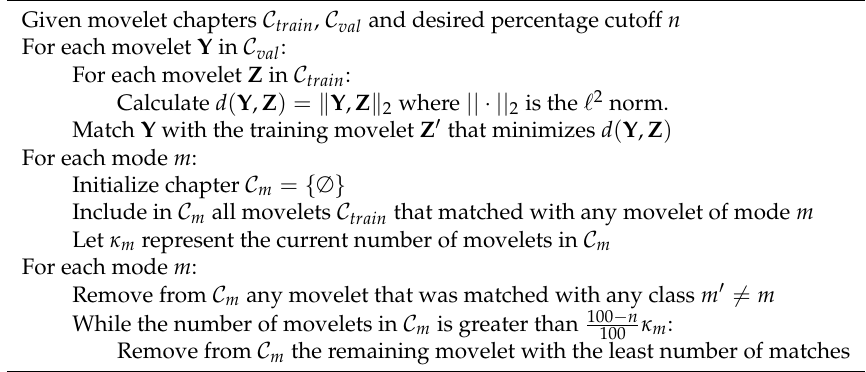
Algorithm 2 Pseudocode for Refining the Training Movelet